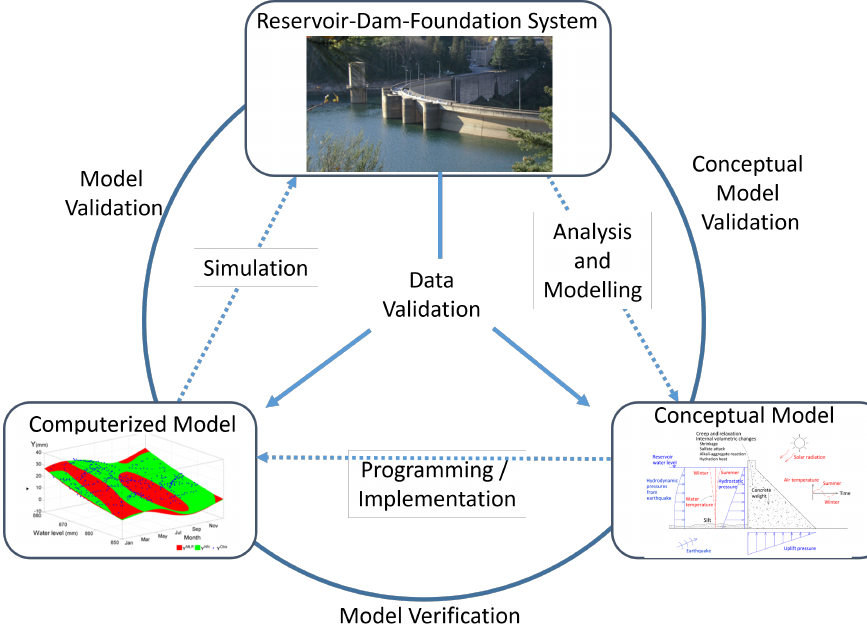
Figure 4. Simplified version of the modelling process for dam engineering, adapted from